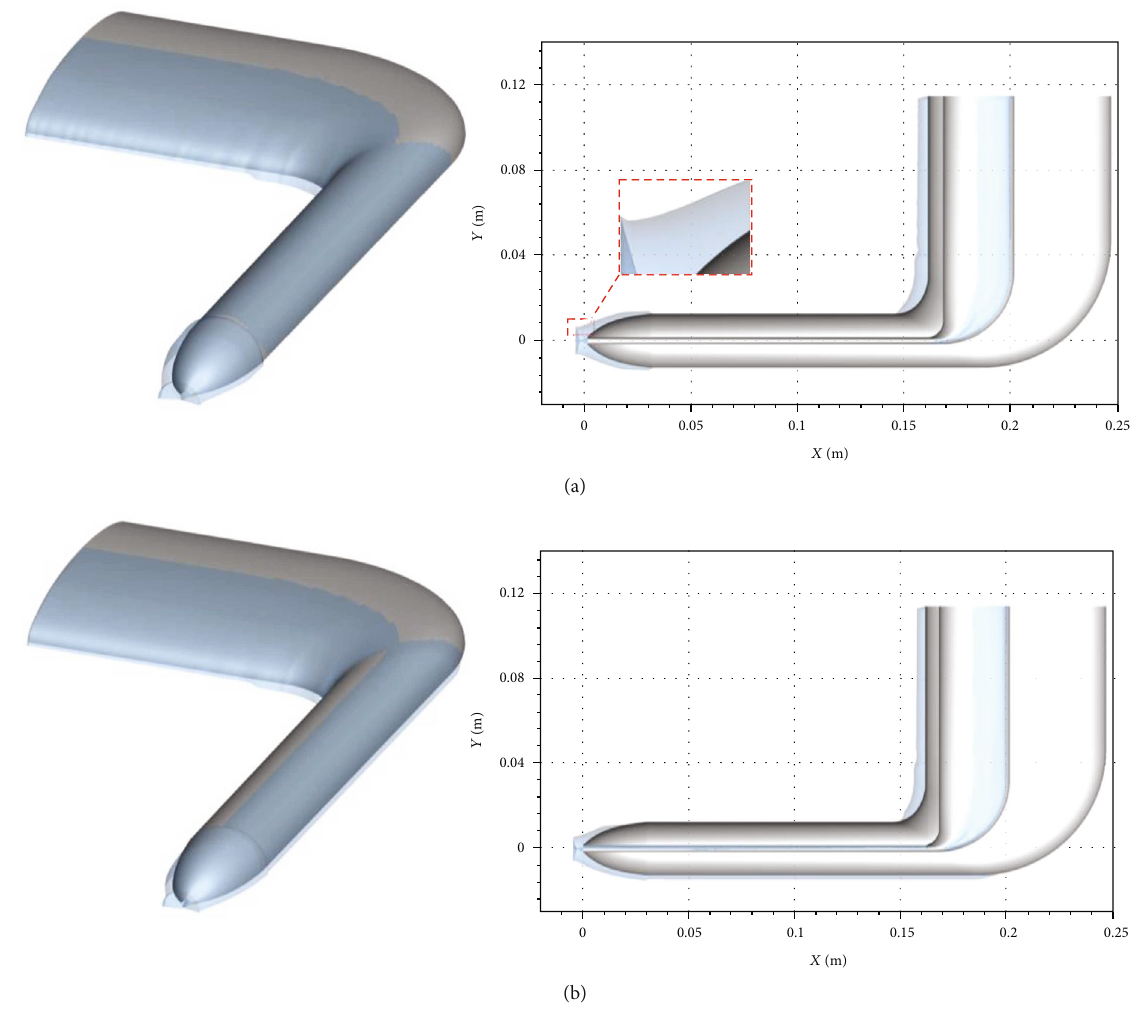
Figure 15: Blocked ice accretion on the pitot-static tube under the glaze ice condition at 262 K and di ff erent AoAs: (a) AoA = 0 ° at a blocking time of 310 s (Case 13); (b) AoA = 10 ° at a blocking time of 279s (Case